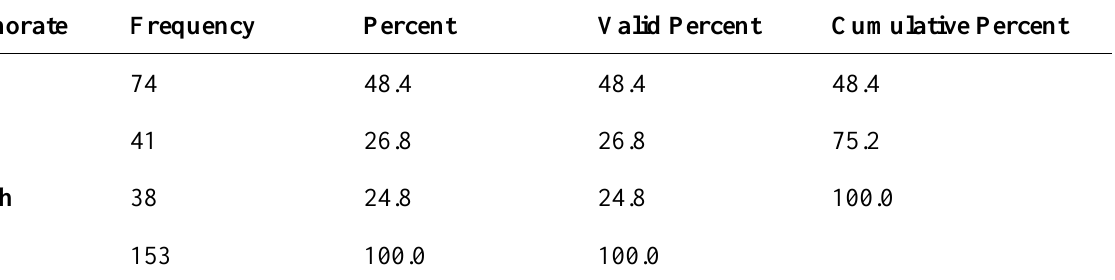
Table 1. The geographical location of the participants Governorate